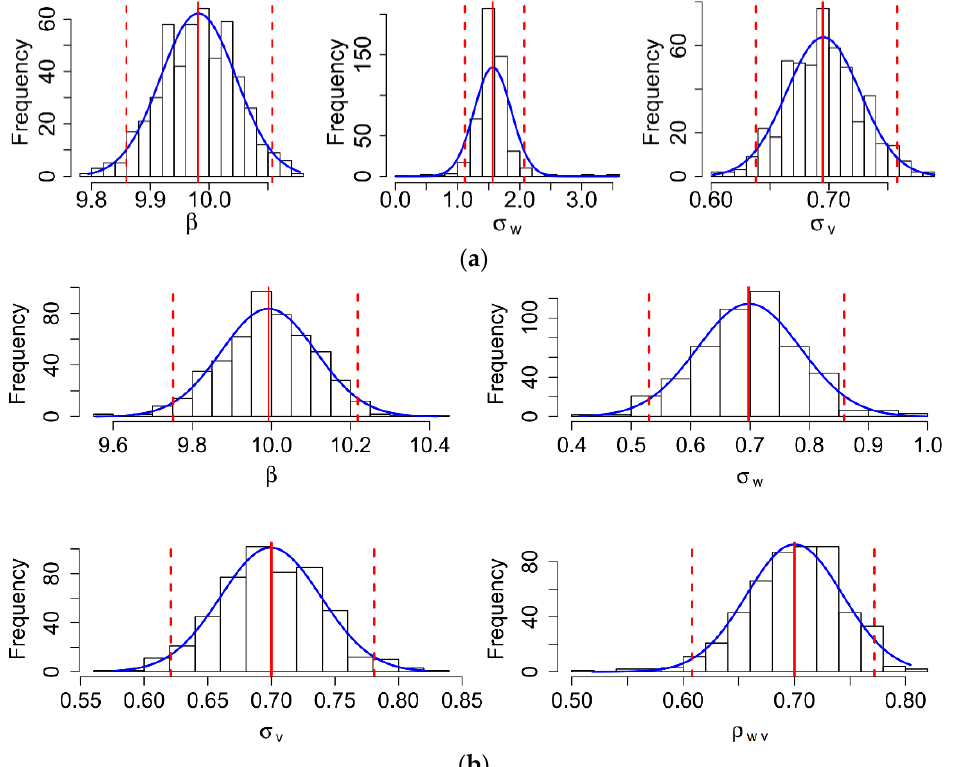
Figure 1. ( a ) Histogram and kernel density of parameters β , σ w , and σ v from conventional SFM. ( b ) Histogram and kernel density of parameters β , σ w , σ v , and ρ wv from copula-based SFM.